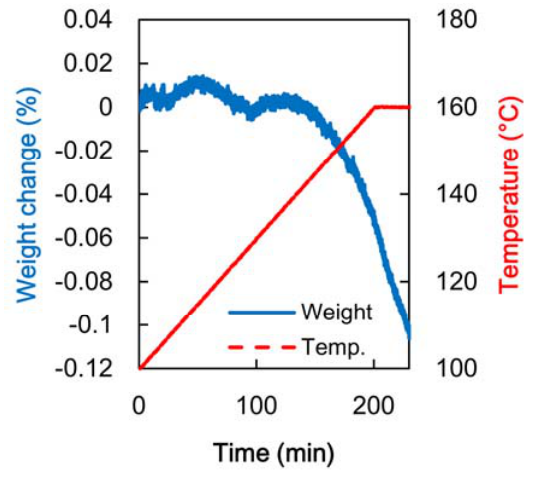
Figure 4. Weight loss determined by thermogravimetry